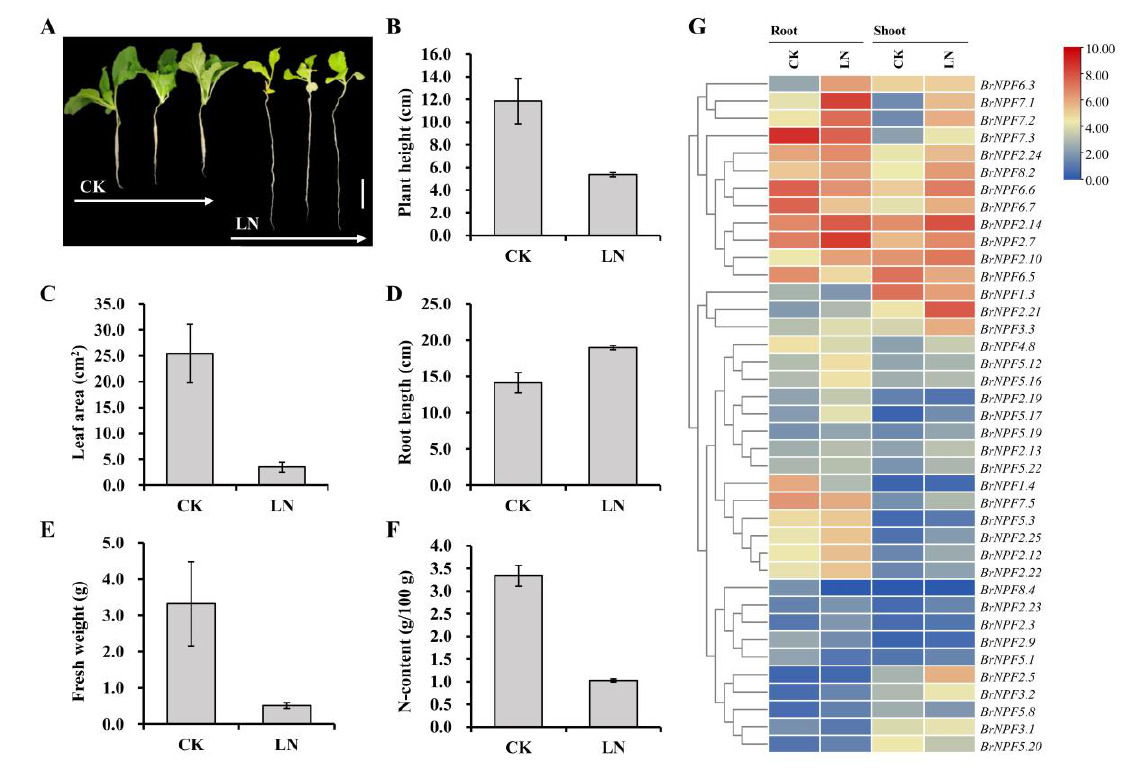
Figure 7. Phenotypic characterization and transcriptome profiling of BrNPFs under low nitrate availability stress. ( A ), Brassica rapa phenotype after low nitrate availability treatment. ( B – F ), Comparisons of plant height, leaf area, root length, fresh weight, and total nitrate concentrations between normal treatment and low nitrate-treated B. rapa seedlings. ( G ), Heatmap visualization of BrNFPs differential expression due to low nitrate stress.